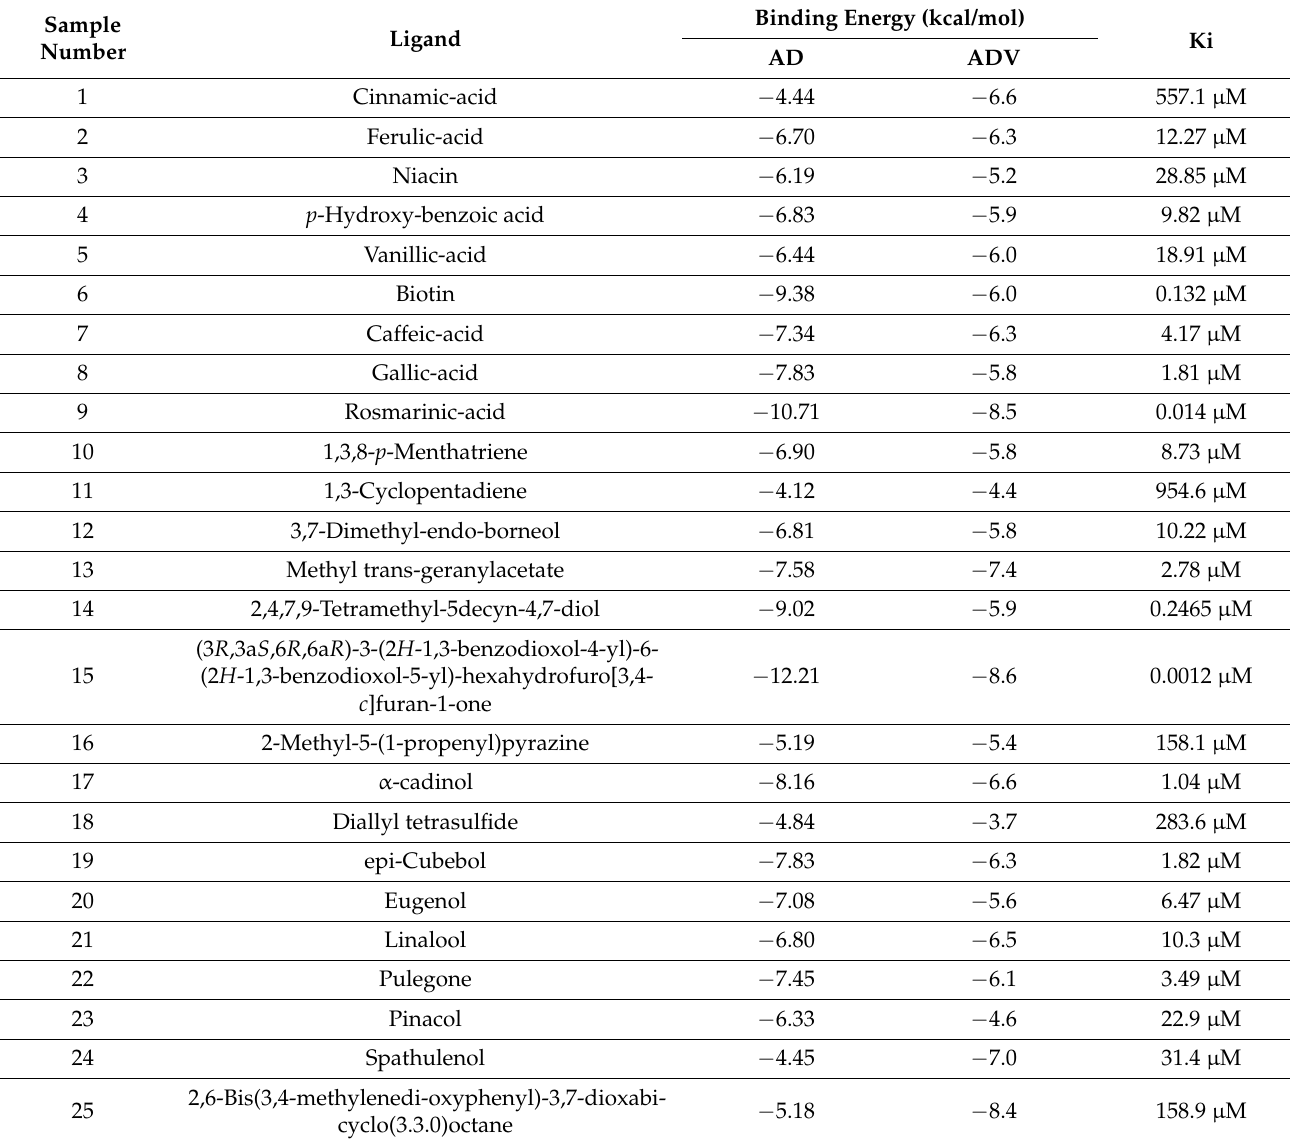
Table 3. Docking results of the compounds against Methyl Coenzyme